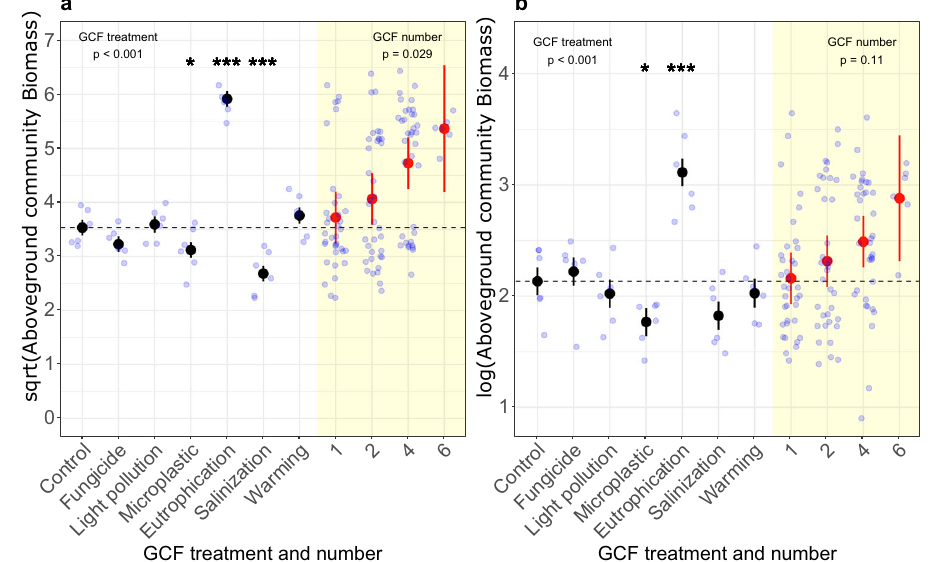
Fig. 1 | Comparison of single-GCF and GCF-number effects on the productivity of transplanted-seedling and sown communities. Aboveground biomass of transplanted-seedling( a )andsown( b )grasslandcommunitiesexposedtodifferent single-GCF treatments (black circles) and to different numbers of simultaneously acting GCFs (red circles). Asterisks indicate signi fi cant single-GCFs (* p <0.05; ** p <0.01; *** p <0.001). For the transplanted-seedling community ( a ), the indivi- dual GCFs microplastics ( p =0.048), eutrophication ( p <0.001), and salinization ( p <0.001) had signi fi cant effects (Supplementary Table 1), and GCF number also had a signi fi cant effect (Supplementary Table 4). For the sown community ( b ), the individual GCFs microplastics ( p =0.026) and eutrophication ( p <0.001) had